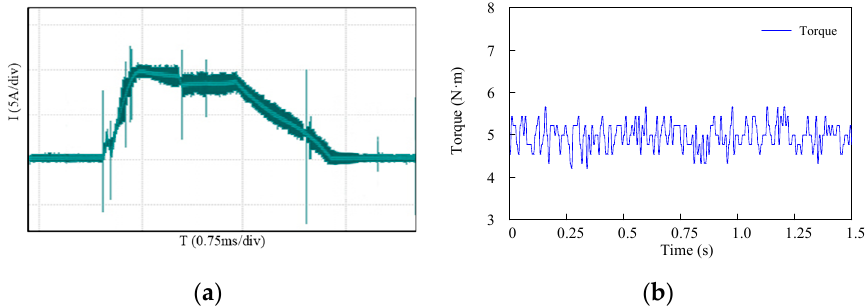
Figure 18. Waveforms of NUTSF at 1000 r/min: ( a ) current; ( b ) torque.